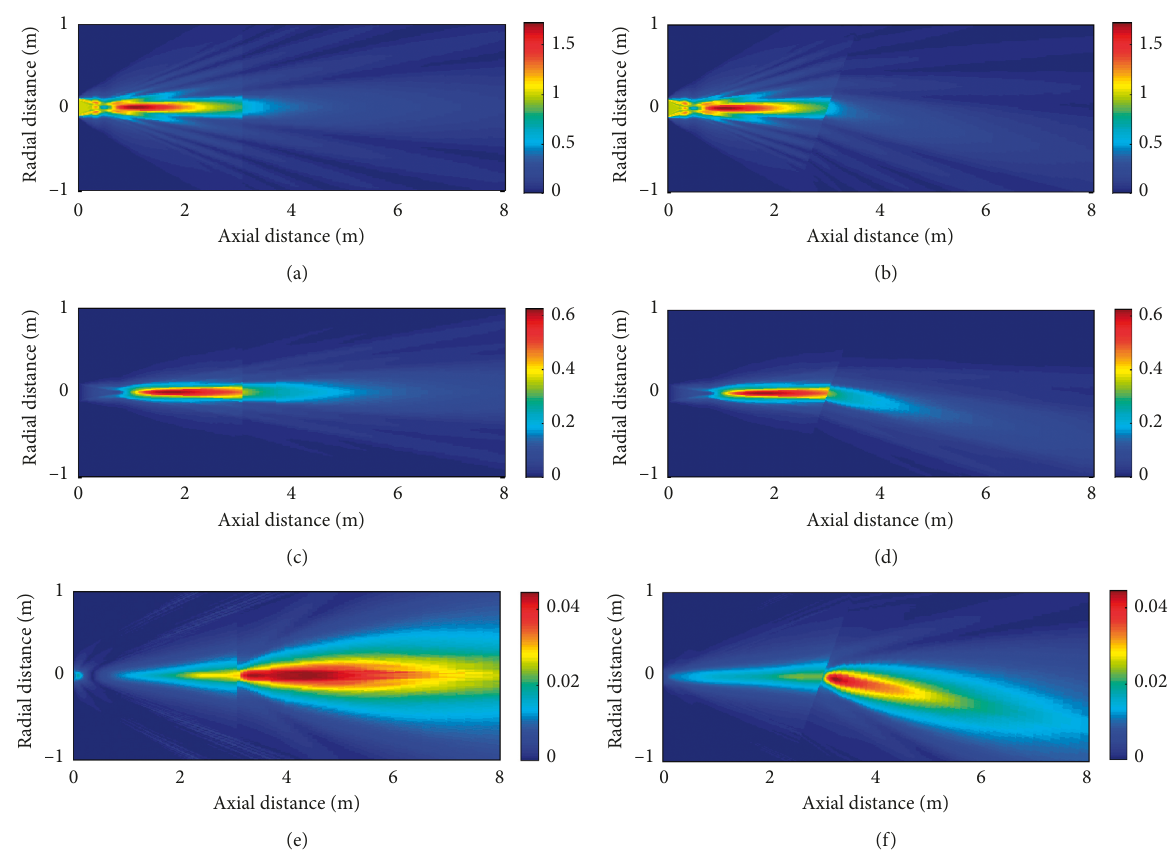
Figure 4: Simulated sound pressure distribution with the different angle incident water-ethanol boundary models. (a) f � 95 kHz, θ � 0 ∘ ; (b) f � 95kHz, θ � 30 ∘ ; (c) f � 205kHz, θ � 0 ∘ ; (d) f � 205kHz, θ � 30 ∘ ; (e) f � 15kHz, θ � 0 ∘ ; (f) f � 15kHz, θ � 30 ∘